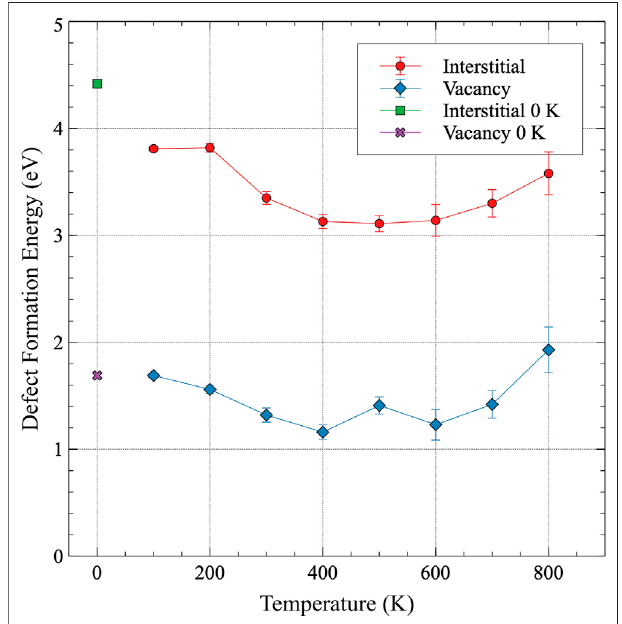
FIGURE 6 | The formation energy of an interstitial and a vacancy in α -U asafunctionoftemperature.ThedefectformationenergiesfrompreviousDFT work are included for comparison Huang and Wirth